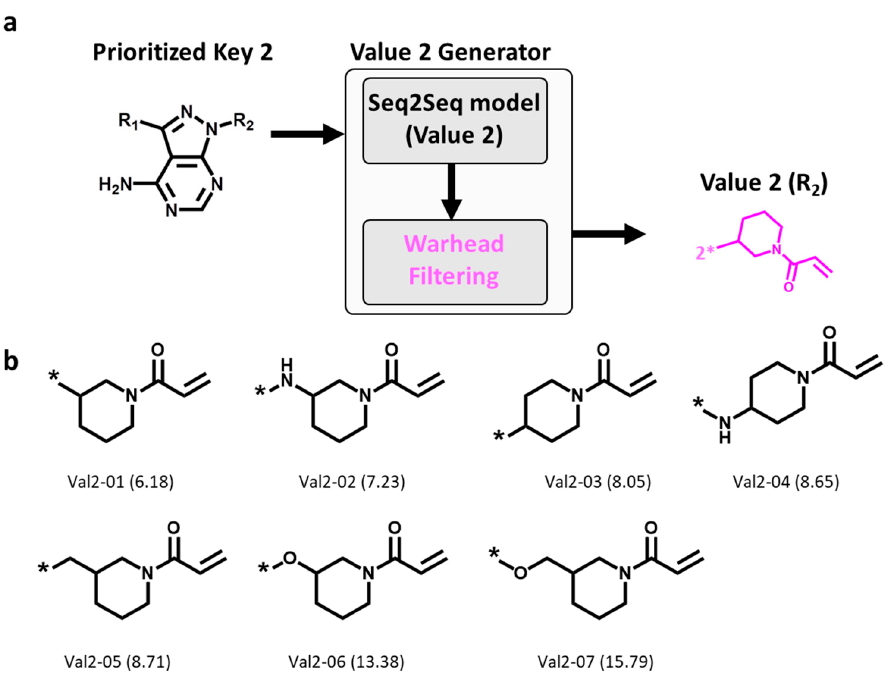
Figure 4. Generation of Value 2 fragments. ( a ) Workflow for generating Value 2 fragments using the Seq2Seq model (Value 2) and warhead filtering, and ( b ) new Value 2 fragments. Below each structure, the identification number and log-likelihood score (in parentheses) are provided. * indicates the fragment attachment point.